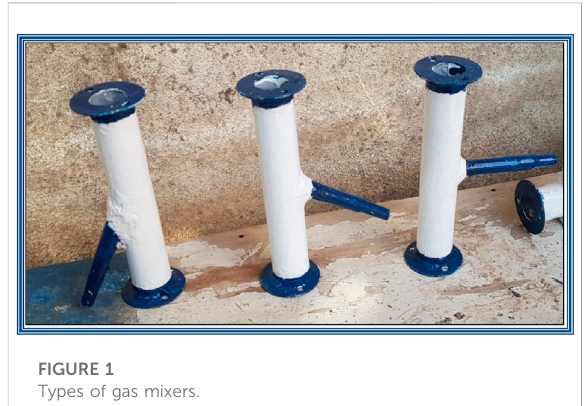
FIGURE 1 Types of gas